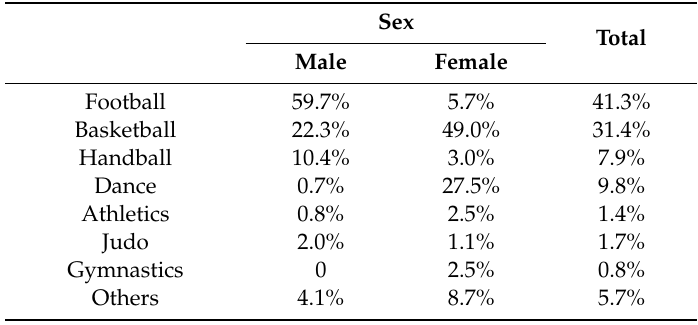
Table 1. Physical / sports activities practised out-of-school